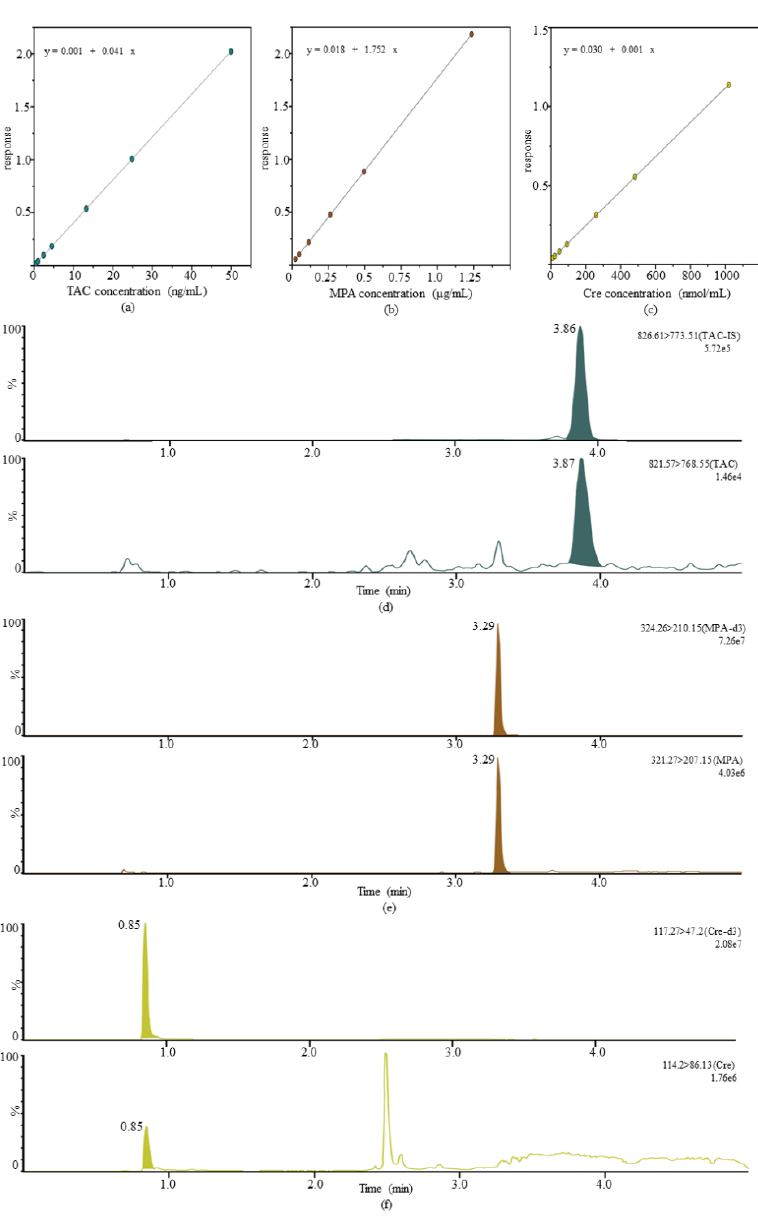
Figure 2. Standard curves and LLOQ ion chromatogram peaks for the three analytes. ( a ) The standard curve range of TAC is 0.50~50.00 ng/mL; ( b ) The standard curve range of MPA is 0.025~1.25 µ g/mL; ( c ) The standard curve range of Cre is 10.00~1000.00 nmol/mL; ( d ) The internal standard channel and analyte channel of tacrolimus LLOQ (0.50 ng/mL) of channel; ( e ) The internal standard channel and analyte channel of mycophenolic acid LLOQ (0.025 μ g/mL); ( f ) The internal standard channel and analyte channel of creatinine LLOQ (10.00 nmol/mL).